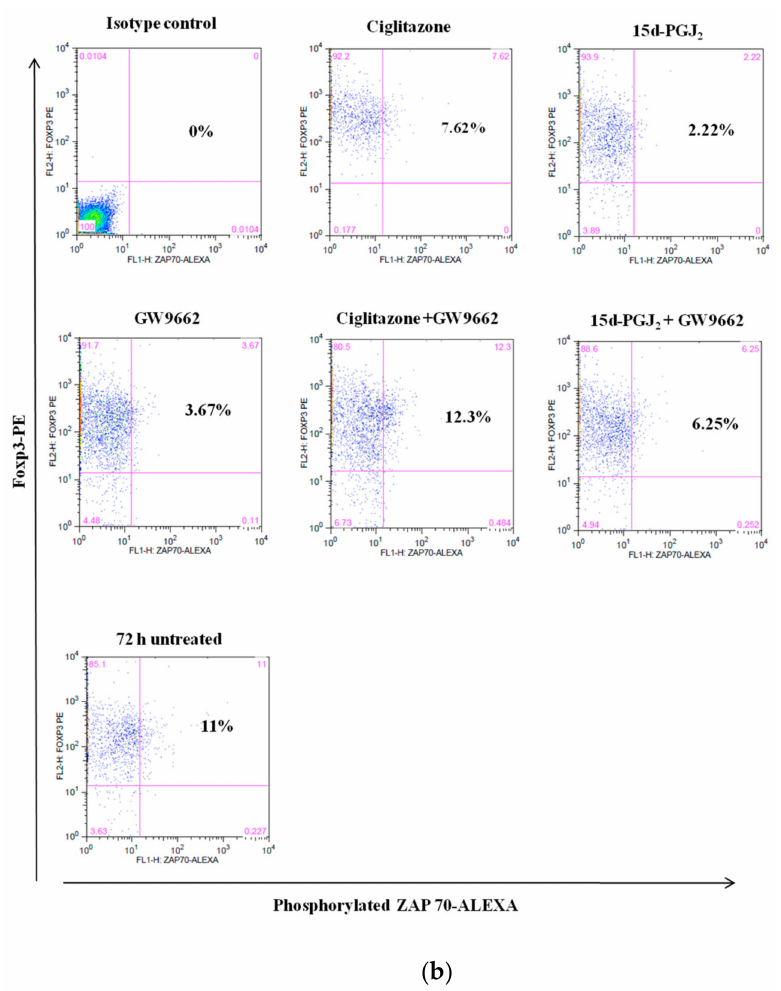
Figure 4. The expression of phosphorylated ZAP-70 in nTreg cells of ( a ) NOD and ( b ) NOR mice following various treatment after 72 h culture. Dot plot shows the levels of phosphorylated ZAP-70 in activated nTreg cells as indicated by Foxp3 expression. ZAP-70 phosphorylation was measured in nTreg cells treated with ciglitazone, 15d-PGJ 2 , GW9662, combination of ciglitazone + GW9662, and combination of 15d-PGJ 2 + GW9662. 72 h-untreated cells were assigned as control group. Data shown are representative of two independent experiments. ( n = 2